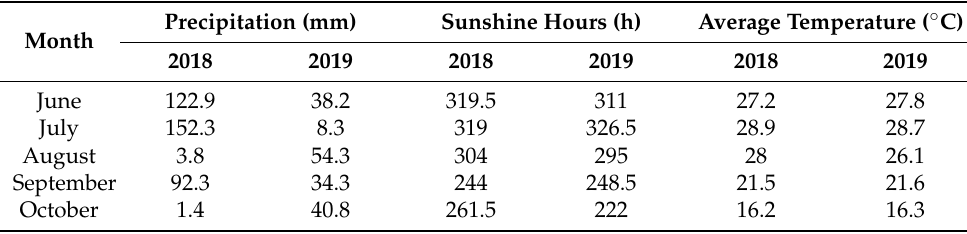
Table 1. The soil in the test field is clay loam, with the following features: total nitrogen of 1.2 g kg − 1 , available phosphorus 12.9 mg kg − 1 , available potassium 139.1 mg kg − 1 , organic matter 17.8 g kg − 1 , pH 7.6. Table 1. Precipitation, sunshine hours, and average temperature during the summer maize growth period in 2018 and